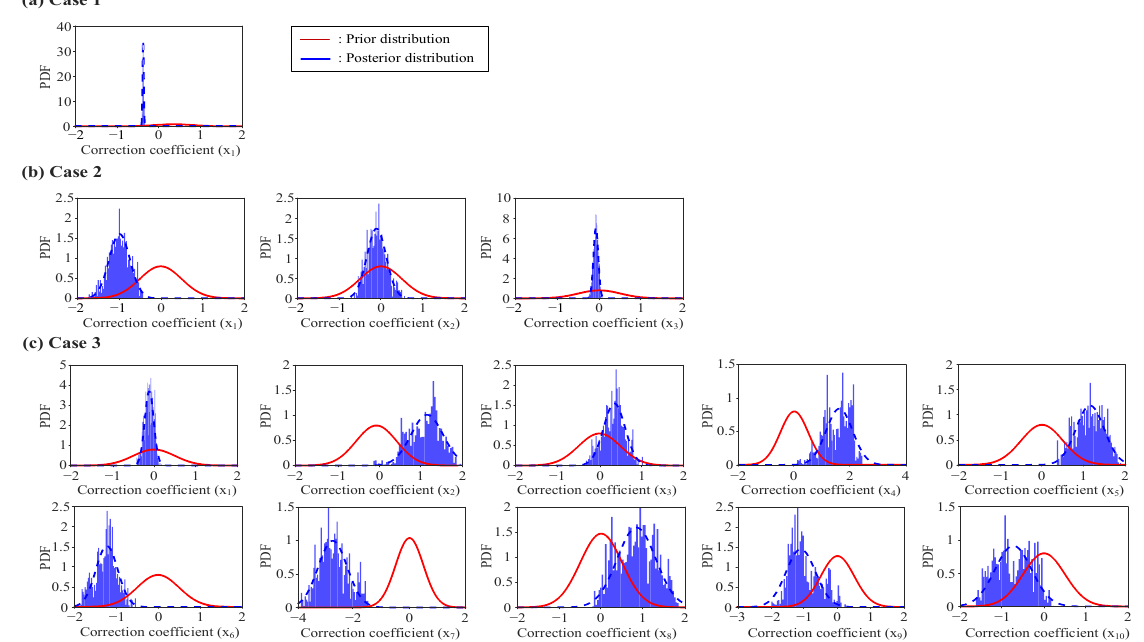
Figure 3. Priors and posteriors for the three calibration cases.